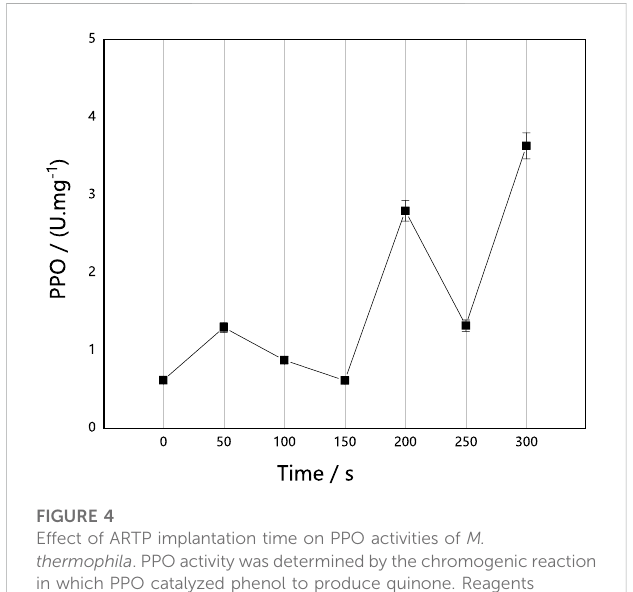
Effect of ARTP implantation time on PPO activities of M. thermophila . PPO activity was determined by the chromogenic reaction in which PPO catalyzed phenol to produce quinone. Reagents preparation and results determination were carried out according to kit requirements. All experiments were carried out four times (biological duplicates and technical duplicates) and mean values presented with standard deviations.